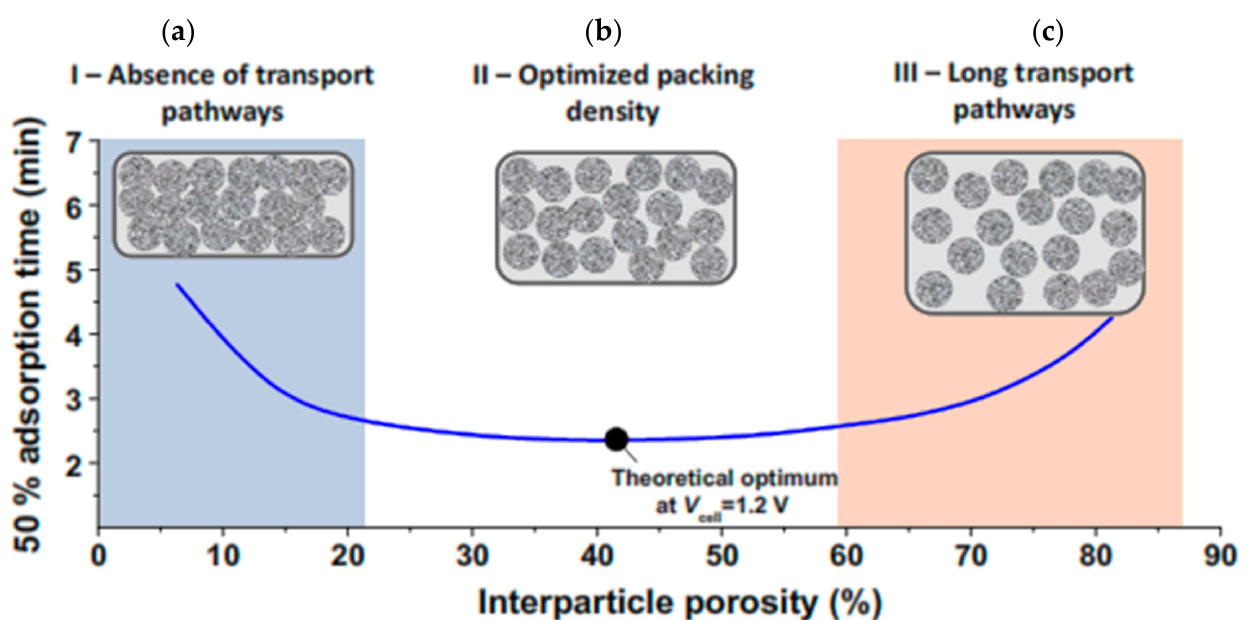
Figure 18. Effect of electrode density and compression on the time required for maximum salt adsorption capacity. ( a ) Compressed and limited state for ion movement, ( b ) Optimal electrode compression state, ( c ) Non-compressed state and maximum porosity space between particles. Reproduced from Ref. [78] with permission from the Royal Society of Chemistry.